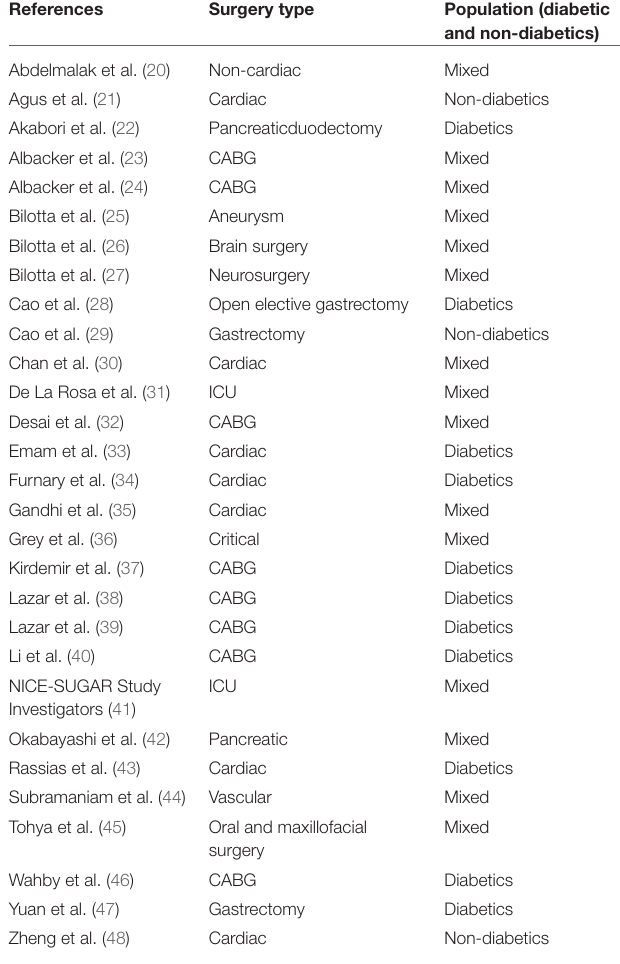
Frontiers in Surgery |